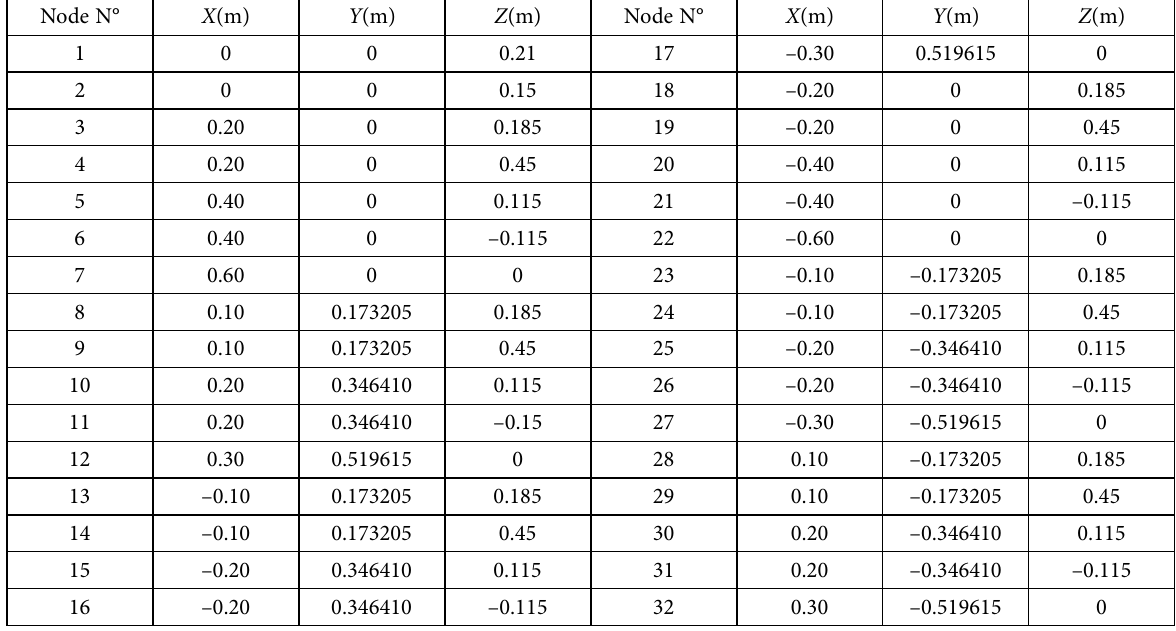
Table 5. Initial coordinates of the smart Geiger’s dome